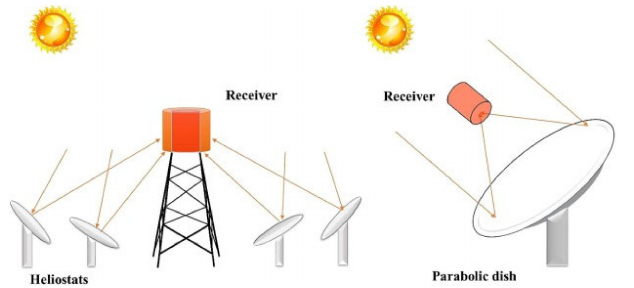
Figure 1. Schematic representation of a heliostat field ( left ) and a parabolic dish system ( right ), which are two well-developed technologies used to concentrate sunlight [38].